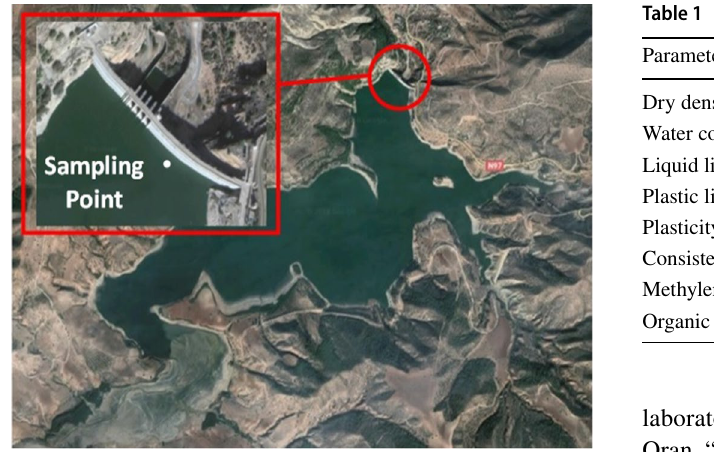
Fig. 2 Location of the samples taken at the upstream of the Chorfa dam